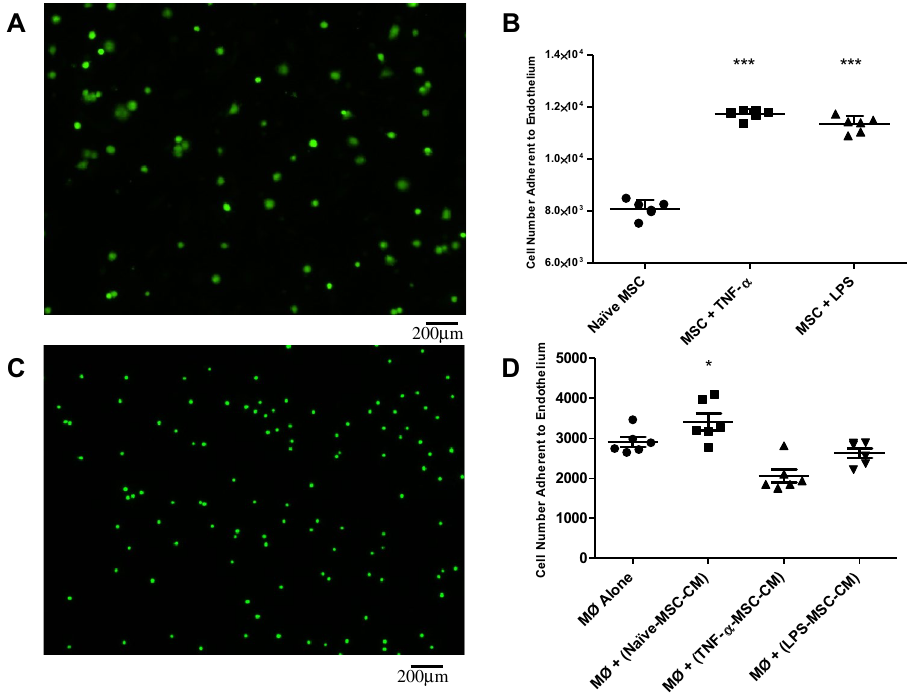
Figure 1. In situ adhesion assays were performed using fluorescently labelled MSCs or monocytes (Mo) added to TNF-α-activated monolayers of hPMVECs. Pre-activation of MSCs with TNF-α or LPS enhanced MSC adhesion ability ( A , B ). Treatment of U937 monocytes with conditioned media from Naïve MSCs allowed for greater adhesion, however conditioned media from MSCs pre-treated with inflammatory cytokines did not enhance this effect ( C , D ). MSC: Mesenchymal Stem Cell; TNF-α: Tumour Necrosis Factor α; hPMVEC: human pulmonary microvascular endothelial cells; LPS: Lipopolysaccharide; Mo: Monocyte; CM: Conditioned Media. Columns represent mean + SD (n = 6), * = P < 0.05 versus